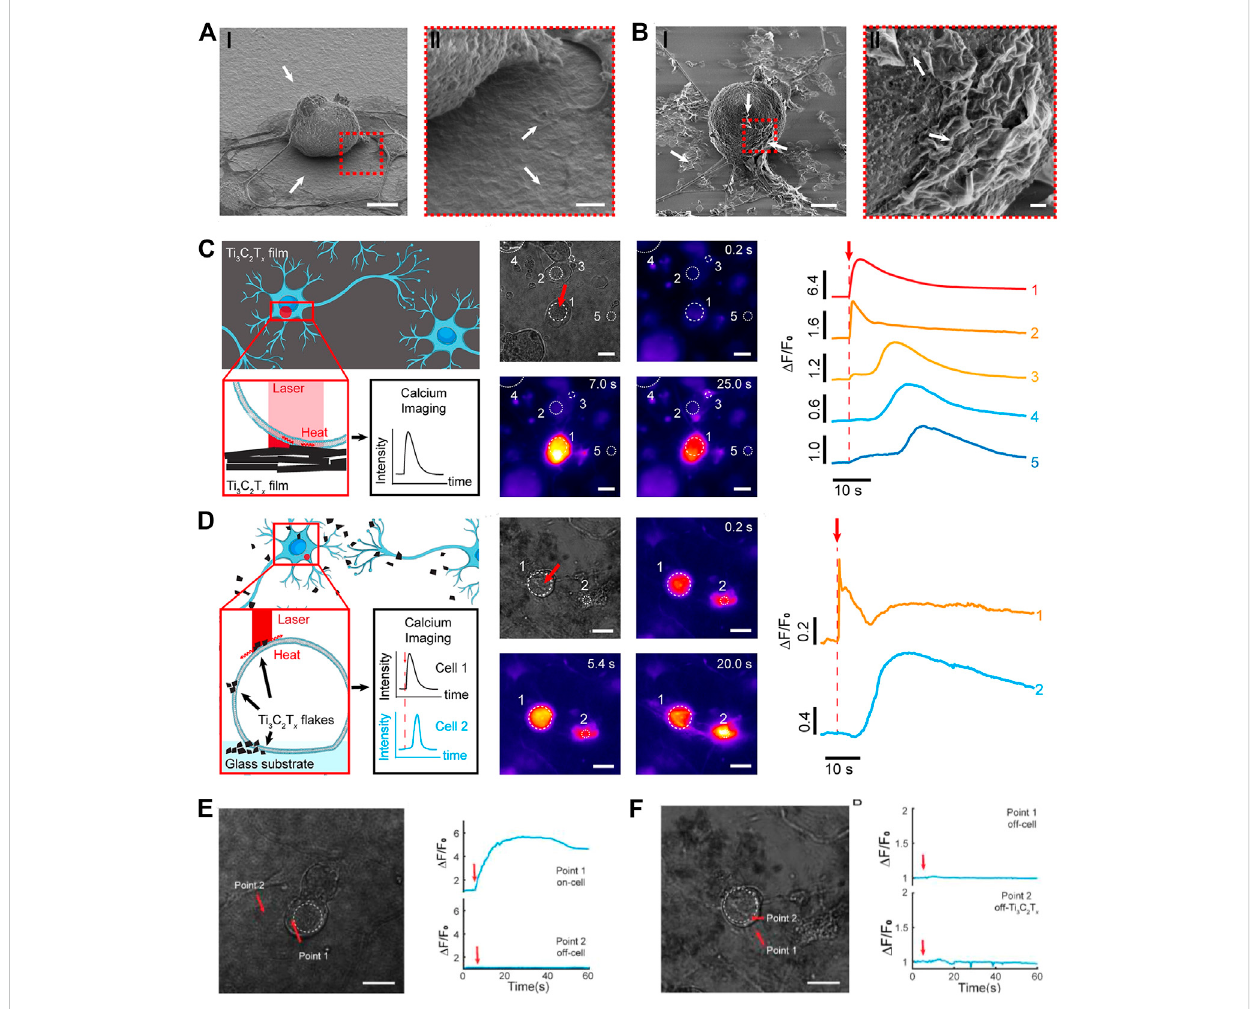
FIGURE 5 (A) SEM images of theinterface between Ti (C) Illustration of